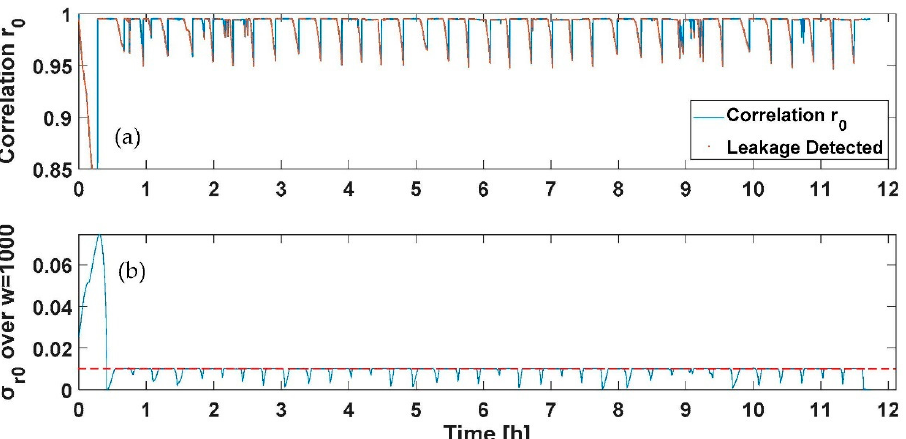
Figure 10. Test on dynamic profile with a continuous leakage for the multijet water meter: ( a ) the r 0 correlation and the point detected corresponding to consumption in red, and ( b ) the moving average σ r0 and in red the threshold retrieved from Table 3 to discriminate a flow rate different from zero.